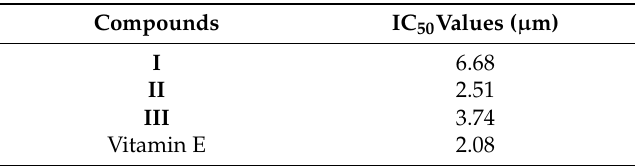
Table 2. Antioxidant activities of Compounds I – III